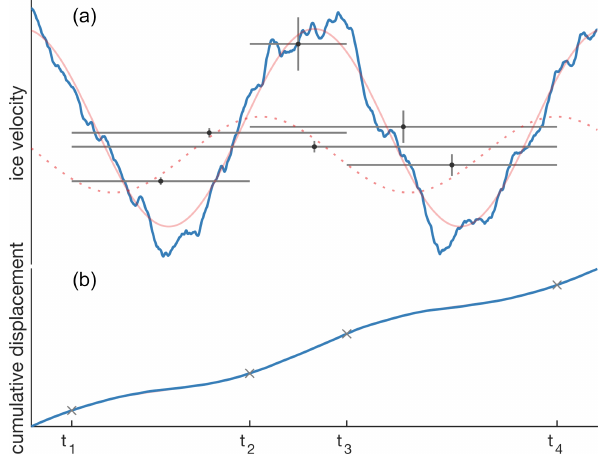
Figure 1. Example scenario: (a) shows an ice velocity time series in blue, which integrates to form the cumulative displacement time series shown in (b) . We use satellite images to measure ice veloc- ity as the cumulative displacement of crevasses and other glacier features that occurs between acquisition times of any two satellite images. Here, four images taken at times t 1 through t 4 provide six unique combinations of image pairs that yield the measurements de- picted as horizontal gray lines connecting the acquisition times of each image pair. Vertical gray lines show measurement uncertainty, and a black dot is placed at the center times of each image pair for visual clarity. A dashed sinusoid is fit to velocity measurements at the center times of each image pair to highlight the inadequacy of fitting directly to velocity data for determination of seasonal am- plitude or phase. This paper describes an alternate, exact approach, wherein sinusoids are fit to accumulated displacements, which are then converted to velocity to produce the light-red velocity sinusoid shown in (a)